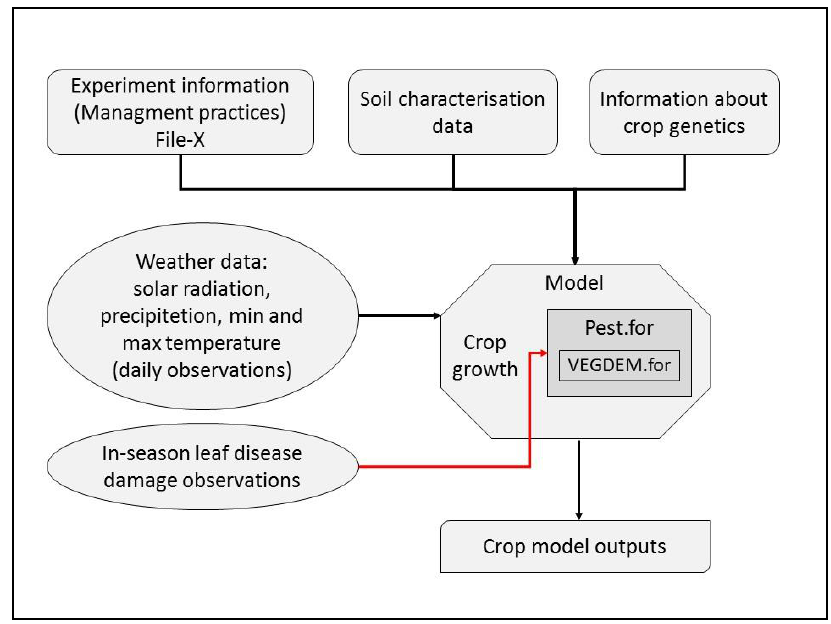
Figure 3. Crop model inputs: experimental file, soil characterisation file, genotype file and daily weather observations in the model with pest modular structure and vegetation damage coupling point.